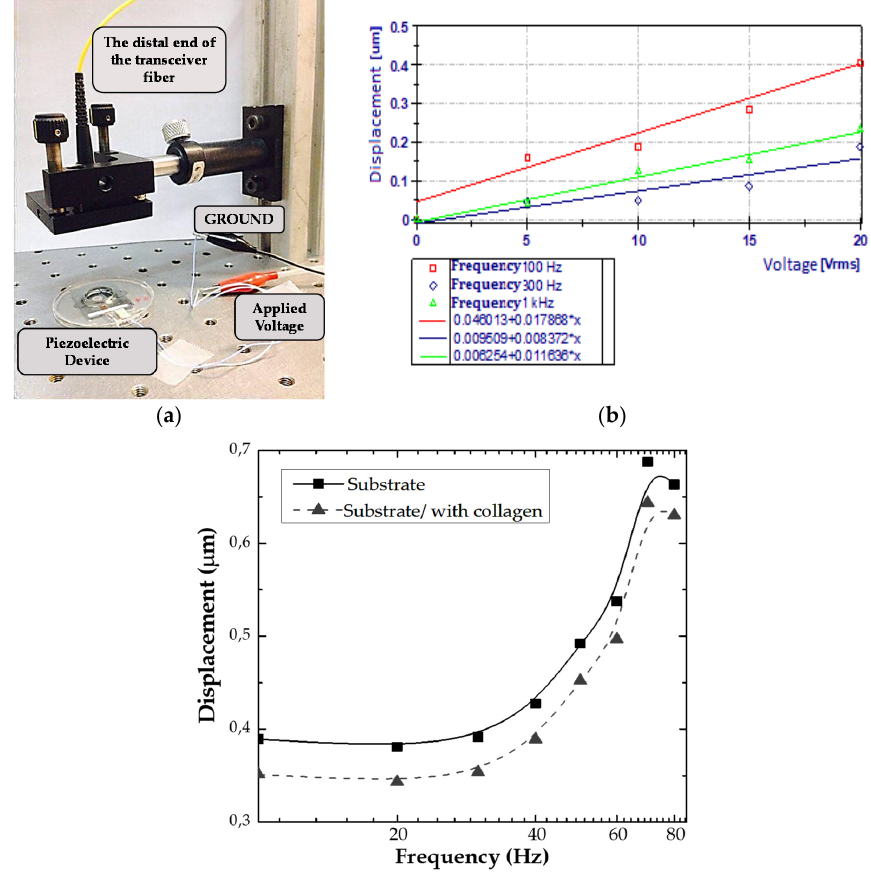
Figure 3. ( a ) interferometric layout for analysis of the piezoelectric device; ( b ) plot showing a linear relation between piezo actuator input voltage and output amplitude for several frequencies; ( c ) response curve of the PVDF (mechanical deformation) vs. the applied frequency in the device. The curve shows negligible differences between the response of the PVDF functionalized with collagen and without functionalization.